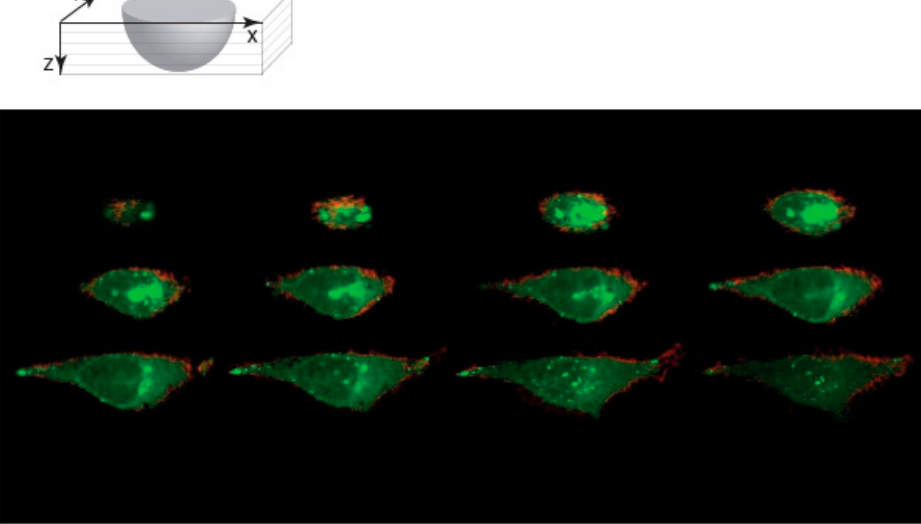
Figure 7. Confocal microscopy of NCNC-IgG conjugates entering cells. HeLa cells were incubated with fluorescently labeled antibodies (Alexa Fluor 488) conjugated to NCNC for 24 h and stained with wheat germ agglutinin. Z stack images were collected of a representative cell as shown. NCNC-IgG conjugates (green) are localized within the boundaries of the cell as shown by WGA (Red).